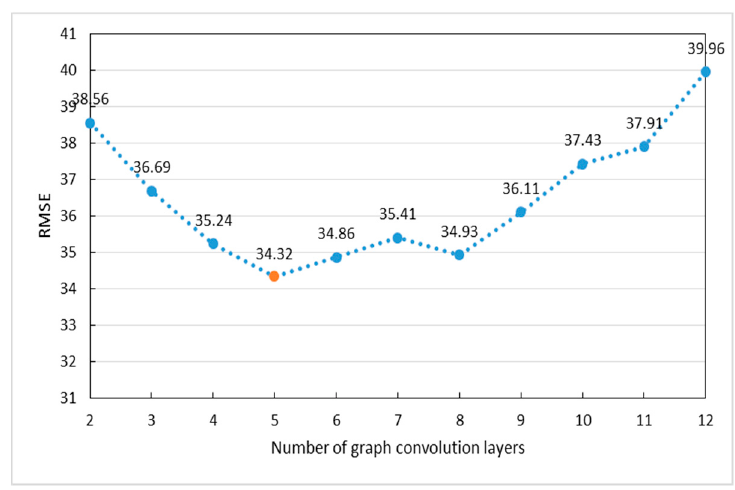
Figure 12. Experimental results with different numbers of graph convolution layers.